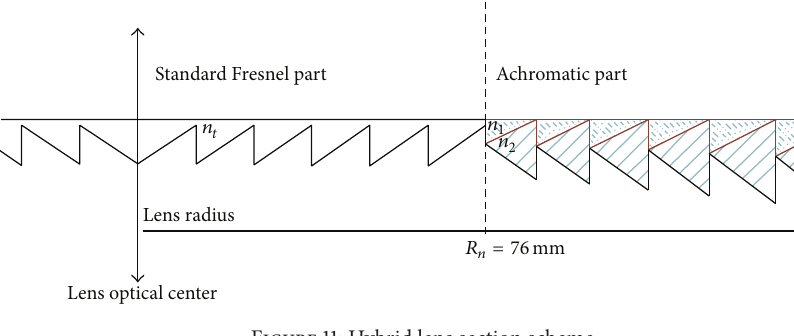
Figure 11: Hybrid lens section scheme.